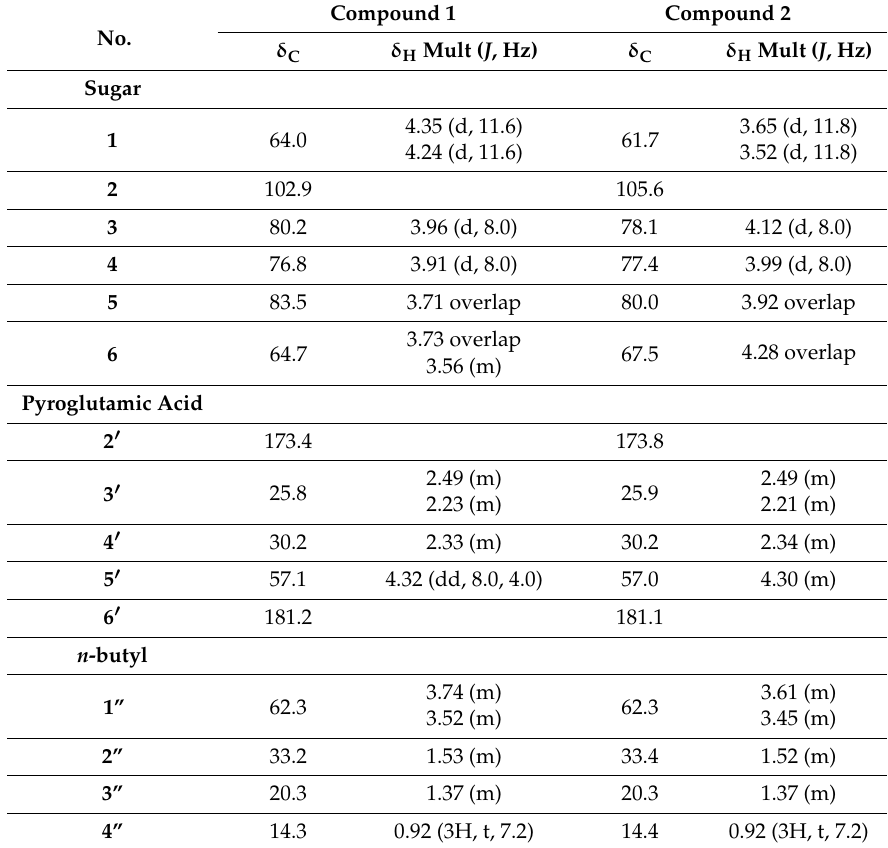
Table 1. 1 H-nuclear magnetic resonance (NMR) and 13 C-NMR data for compounds 1 and 2 (CD 3 OD).